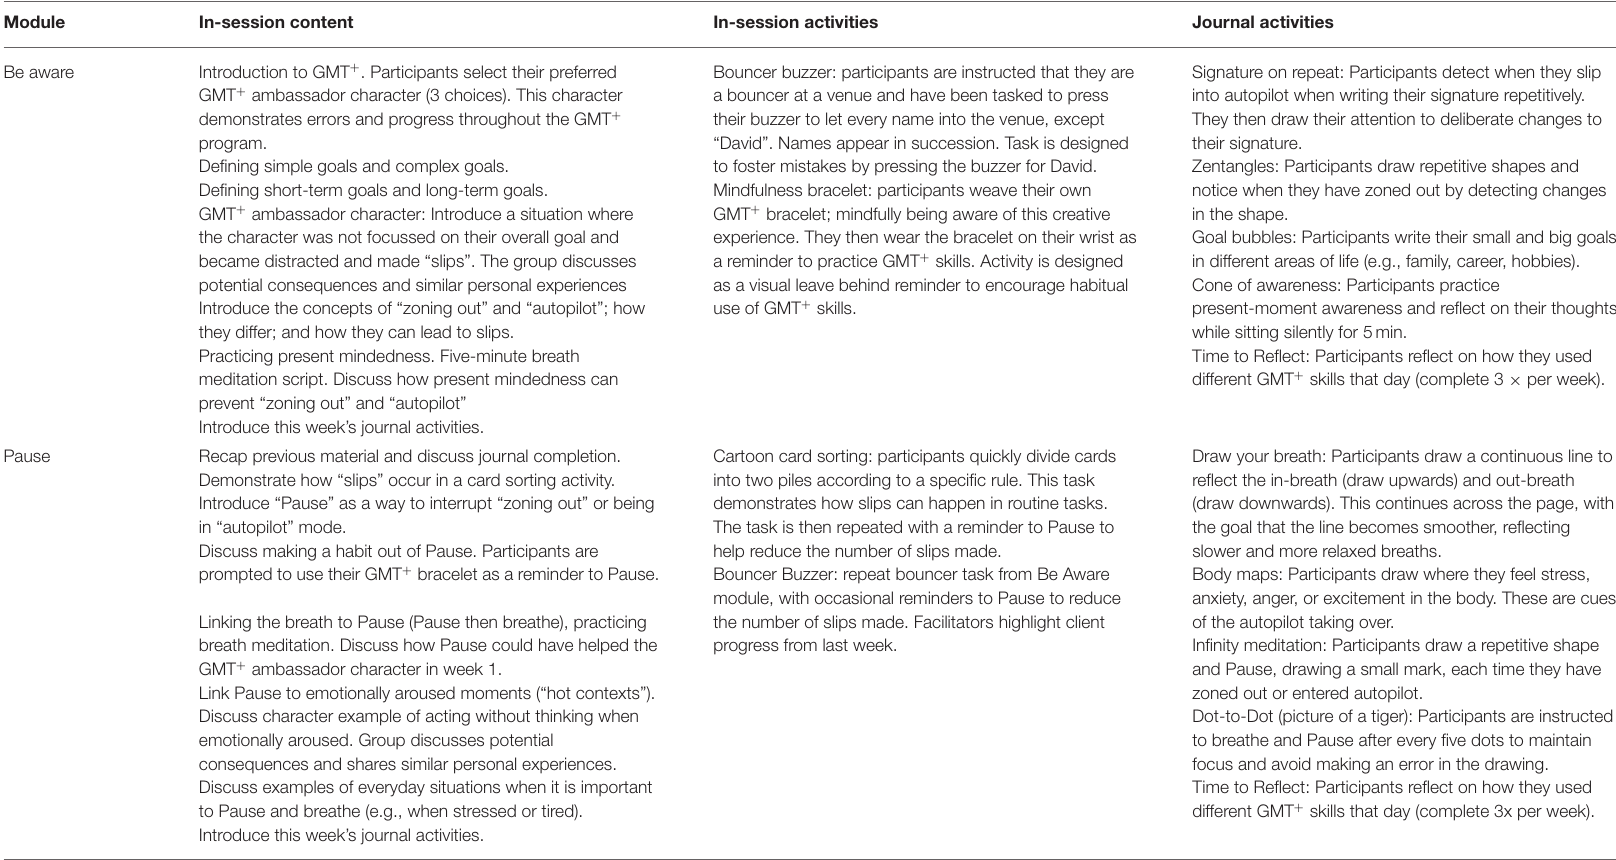
TABLE 1 | Description of in-session content, in-session activities and between-session journal activities for the four GMT + modules.